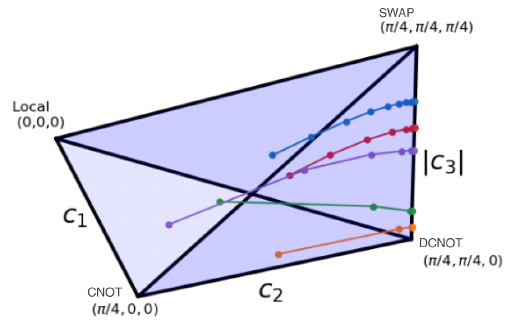
FIG. 4. Trajectories of five random realizations of two-qubit gates are shown inside the Weyl chamber under action of the map for n = 10 steps. The edge joining the SWAP gate and the DCNOT gate corresponds to dual unitaries to which the map